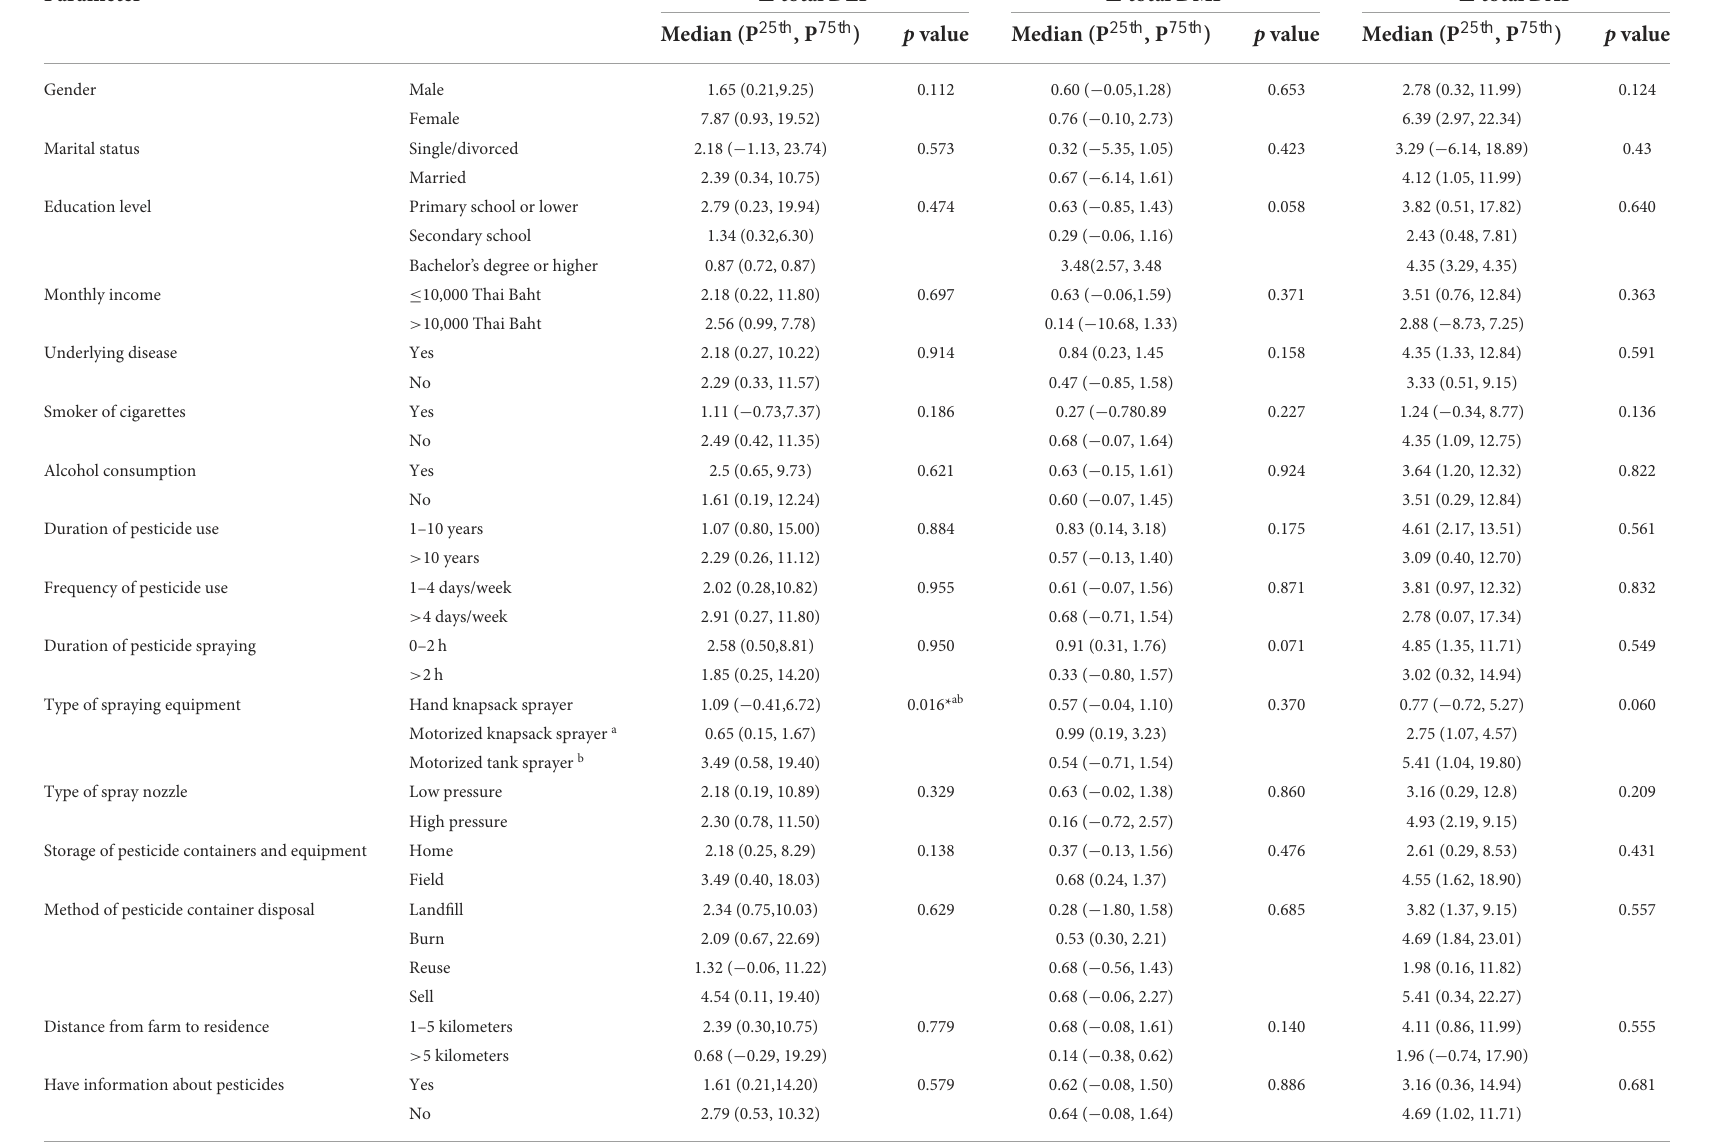
TABLE 3 Change in urinary OP metabolite levels during pesticide application classified by demographic characteristics and agricultural information.